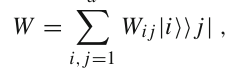
Fig. 5a this operator is represented with an input leg i and an output leg j .